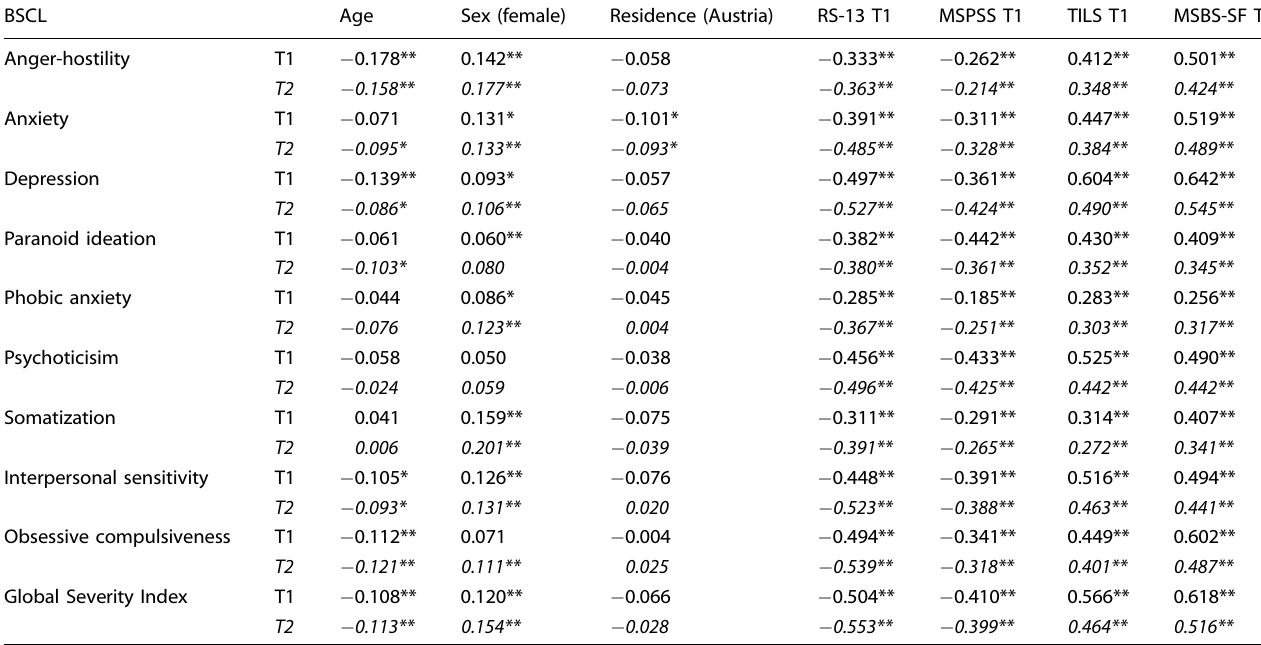
Table 4. Correlations between T1 and T2 variables (Spearman ’ s